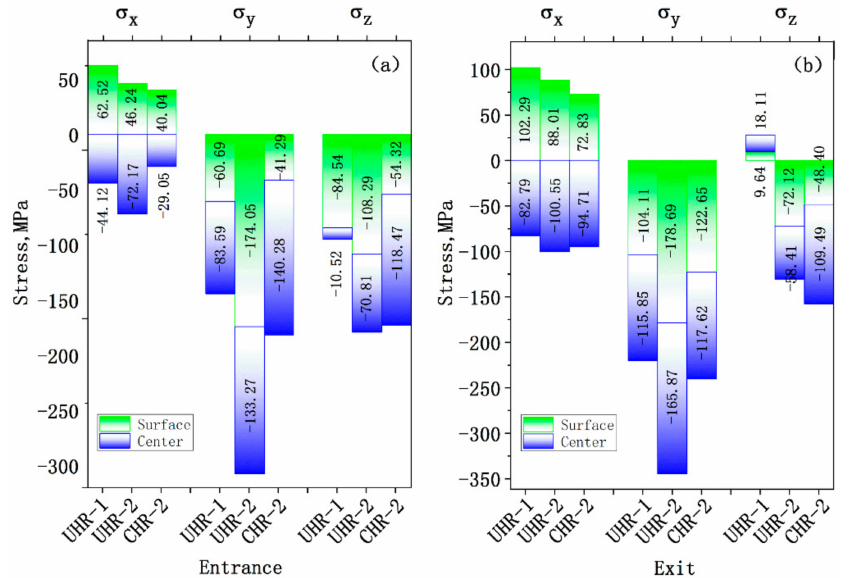
Figure 5. The distribution of additional stress at the ( a ) entrance and ( b ) exit of different passes under the UHR and CHR